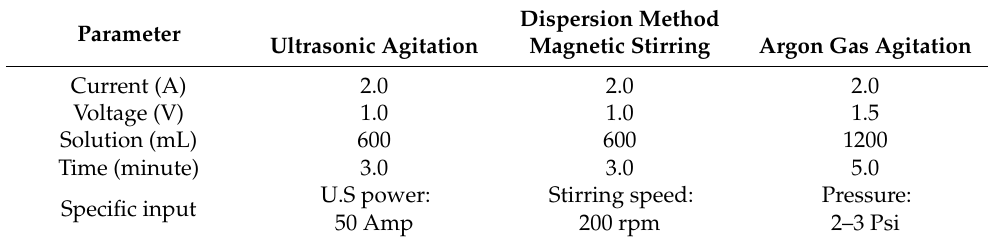
Table 4. Parameters used in the experiments.